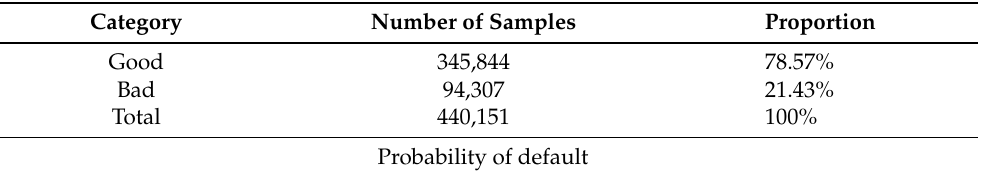
Table 1. Structure of the original data